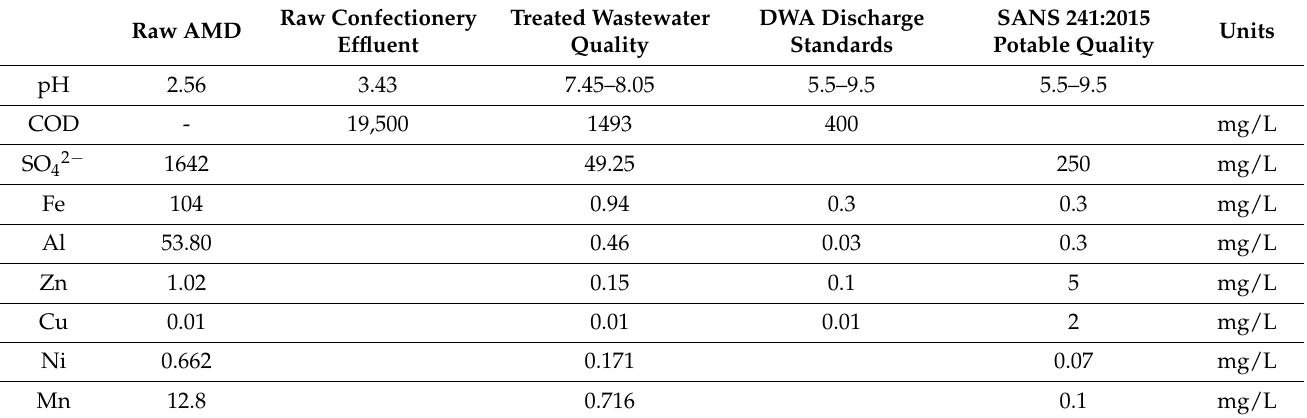
Table 5. Raw and treated wastewater quality vs.